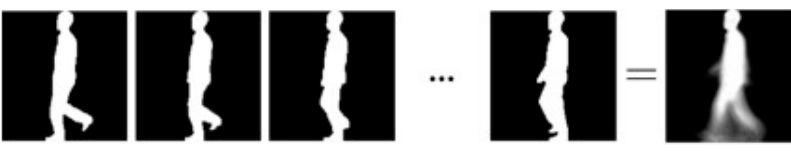
Figure 2. Illustration of GEI.